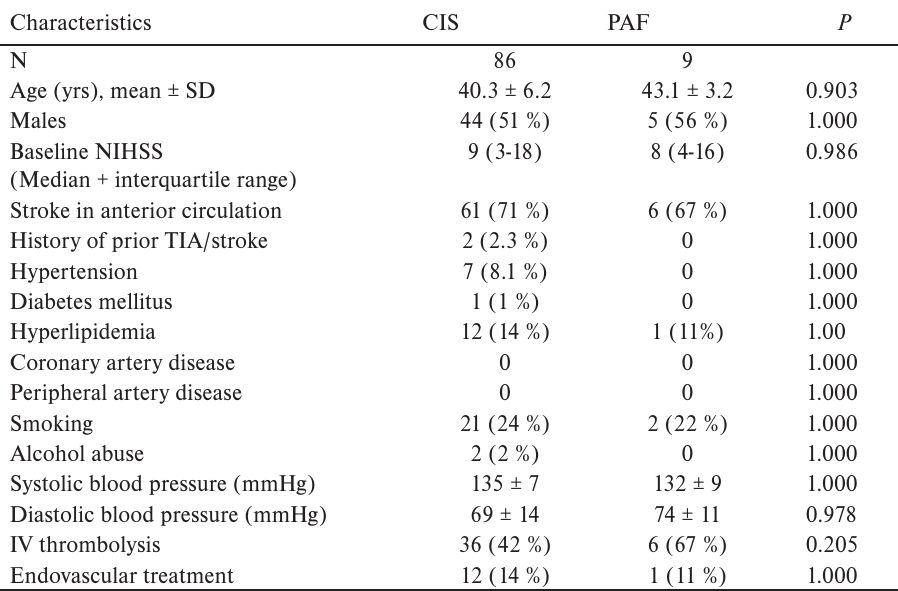
Table 1. Demographic and baseline stroke characteristics of CIS patients and PAF patients.